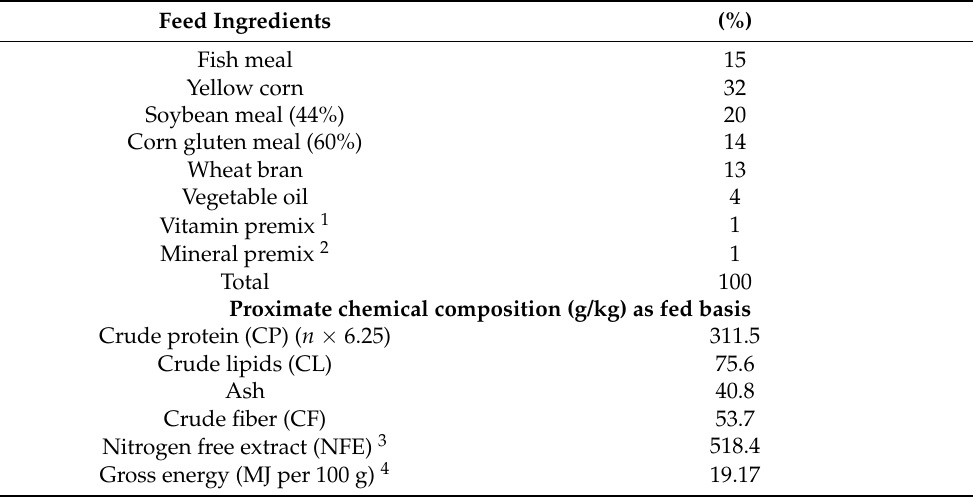
Table 1. Feed ingredients and proximate chemical composition of the commercially purchased basal diet (%) (on air-dry basis) (previously published in Abdelghany et al. [35]). Feed Ingredients (%) Fish meal 15 Yellow corn 32 Soybean meal (44%) Corn gluten meal (60%) Wheat bran Vegetable oil Vitamin premix 1 Total 100 Proximate chemical composition (g/kg) as fed basis Crude protein (CP) ( n ×